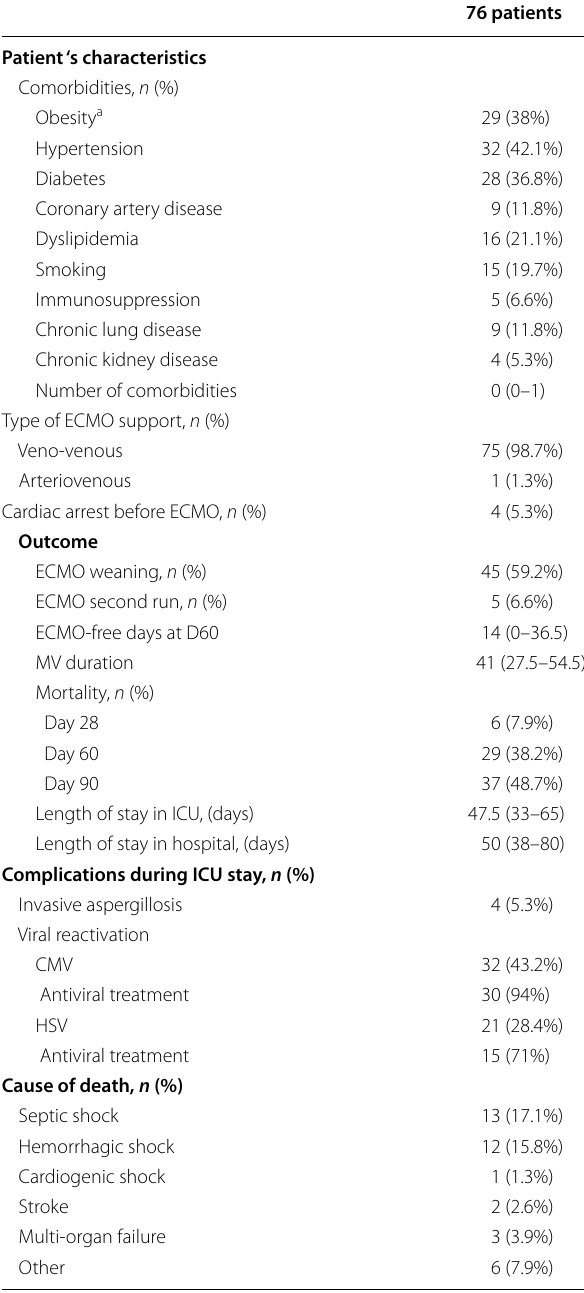
Table 1 Characteristics of the cohort and